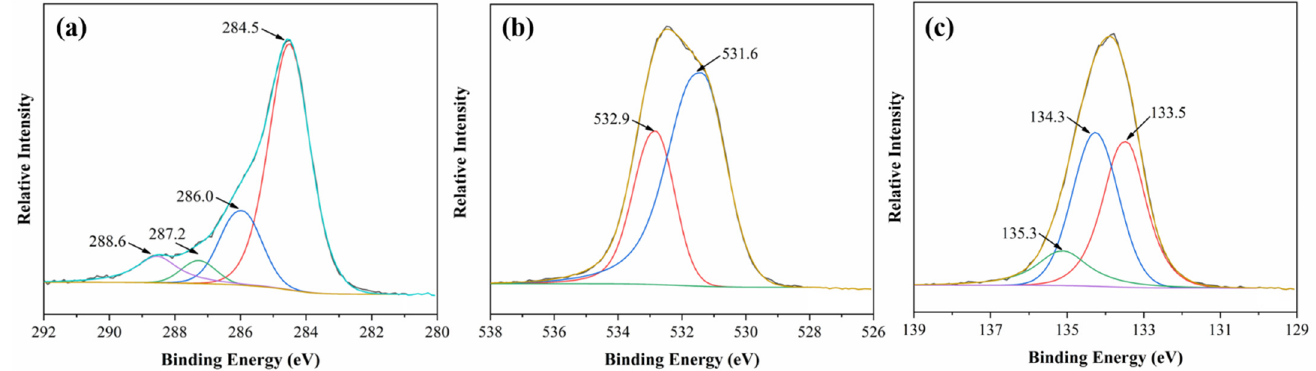
Figure 7. XPS spectra of the residues of the A2C1M1 sample after calcination in a muffle at 550 °C: C1s ( a ), O1s ( b ) and P2p ( c ).